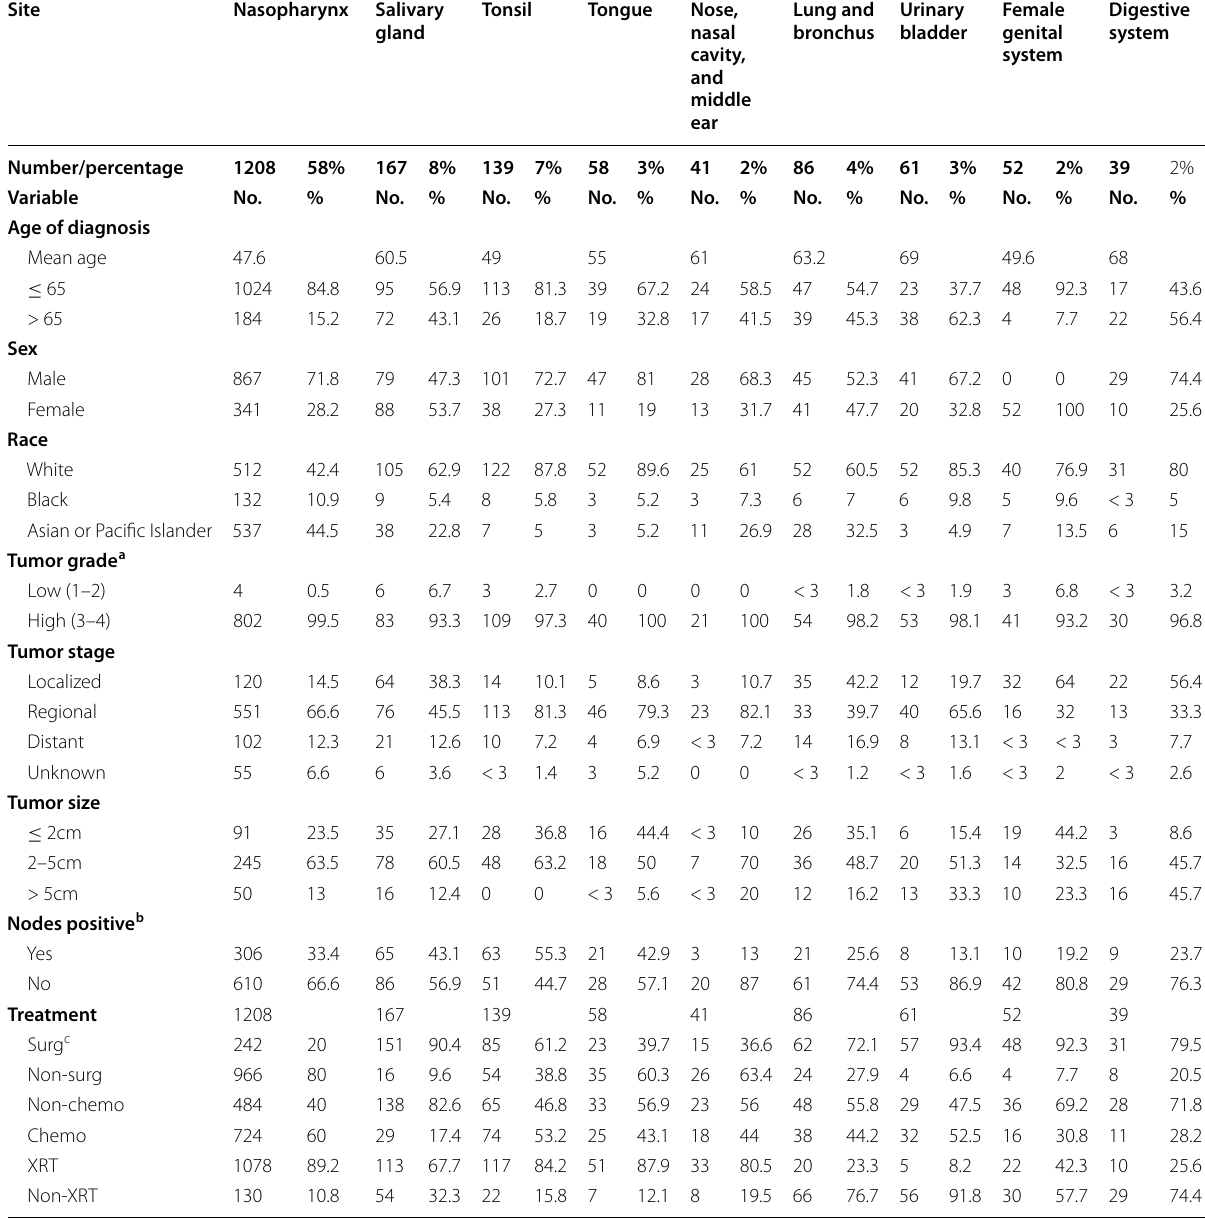
Abbreviations : Surg surgery, XRT radiation therapy, Chemo chemotherapy a Grade: grade 1, well differentiated; grade 2, moderately differentiated; grade 3, poorly differentiated; grade 4, undifferentiated; anaplastic b Nodes positive is only available after 1988